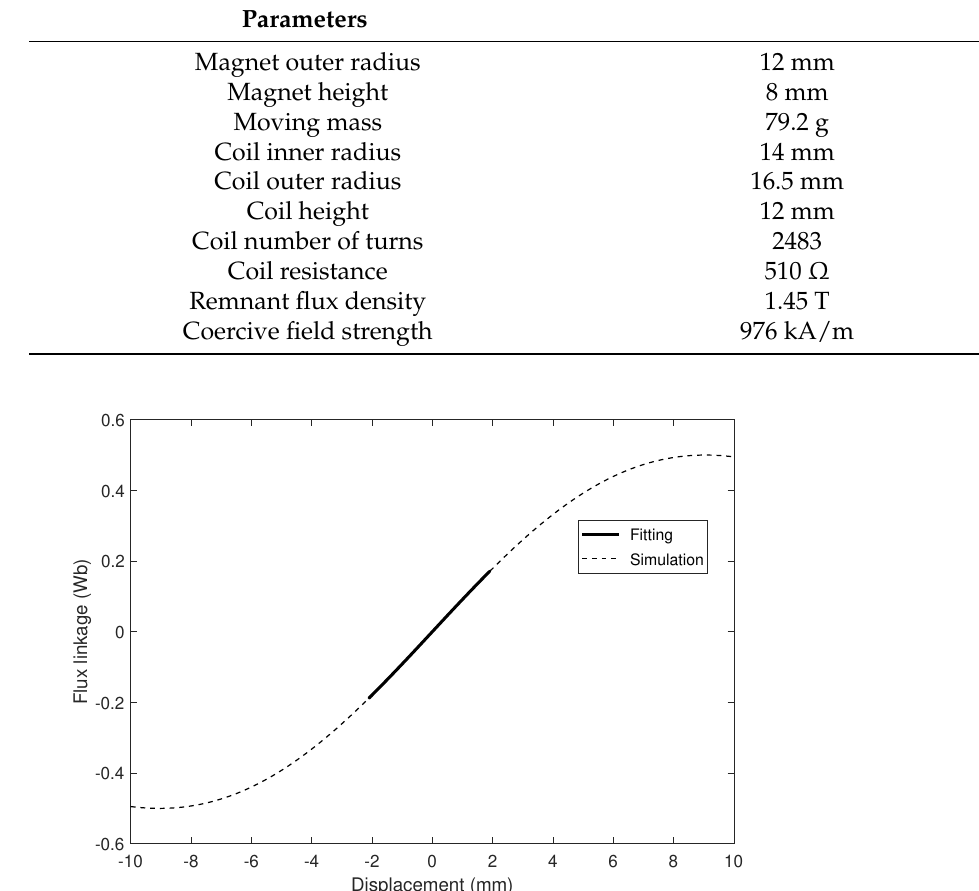
Table 4. Parameters of Halbach array configuration with three magnets and one coil (H3M1C) for verification. Parameters are selected in accordance with [33] to evaluate model implementation.